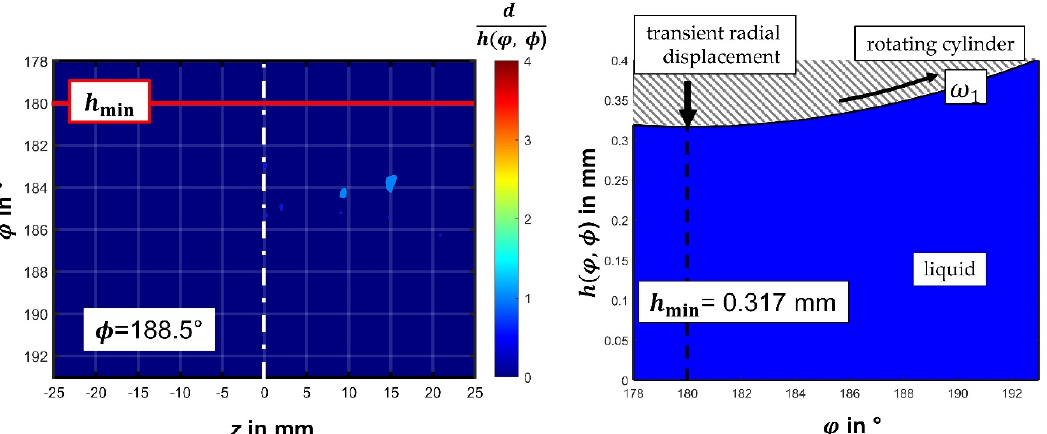
Figure 11. Bubble size in relation to local film thickness with decreasing bubble volume, rotational angle φ = 188.5 ◦ after initiation of transient radial displacement, solely pseudo-cavitation, fluid: paraffin containing 100% dissolved air.